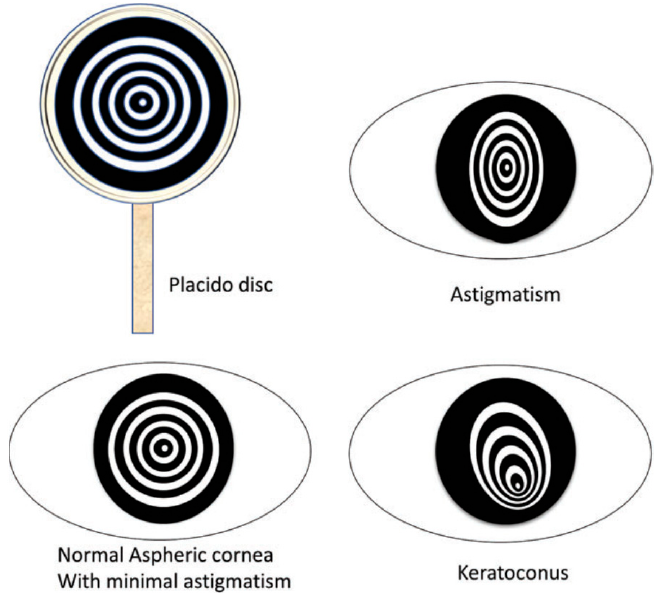
Figure 3. Placido disc and representative patterns of corneal shapes [36].